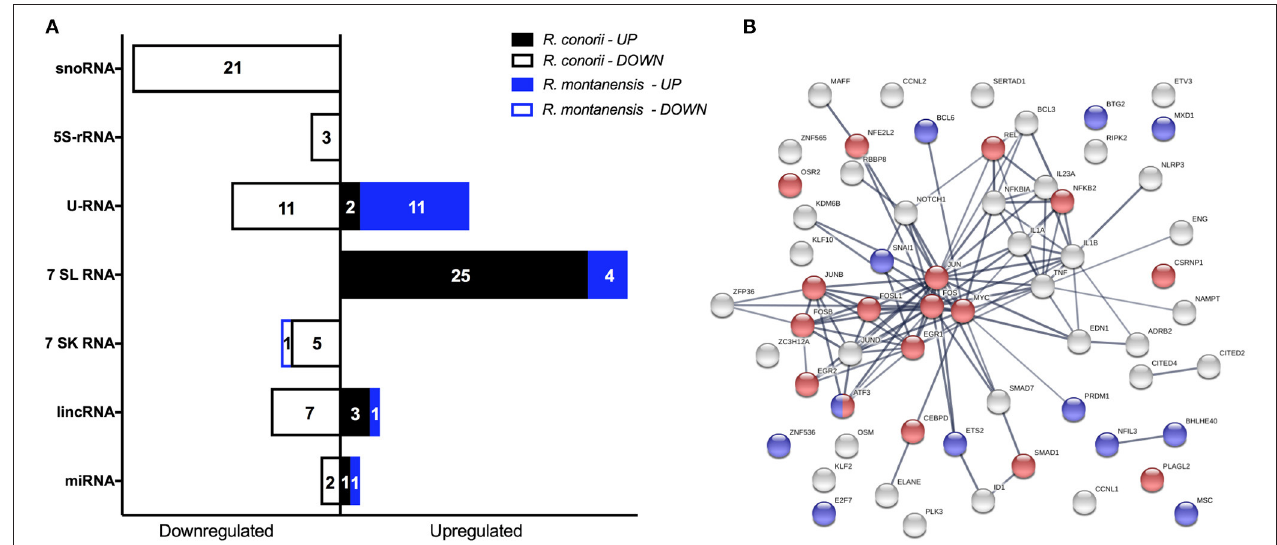
FIGURE 8 | Rickettsia species differentially modulate the expression of several gene expression regulators early in infection of THP-1 macrophages. (A) Distribution of DE non-coding RNAs according to their category in R. conorii - (black) and R. montanensis - (blue) infected cells. scaRNAs (small Cajal body-specific RNAs), snoRNAs (small nucleolar RNAs), 5S-rRNAs (5S ribosomal RNAs), U-RNA (small nuclear RNAs), 7SL RNAs (signal recognition particle RNAs), 7SK RNAs (7SK small nuclear RNAs), lincRNAs (long intergenic noncoding RNAs), miRNAs (microRNAs). Number of genes for each orientation [increased abundance (UP) or decreased abundance (DOWN)] is represented in each bar. See Table S10 for details about individual transcripts. (B) STRING analysis of DE genes in R. conorii -infected cells categorized in the GO term “positive or negative regulators of transcription from RNA polymerase II promoter.” Nodes corresponding to DE genes categorized with transcriptional activator activity (GO:0001228) are in red and with transcriptional repressor activity (GO:0001227) are in blue. See also Table S11